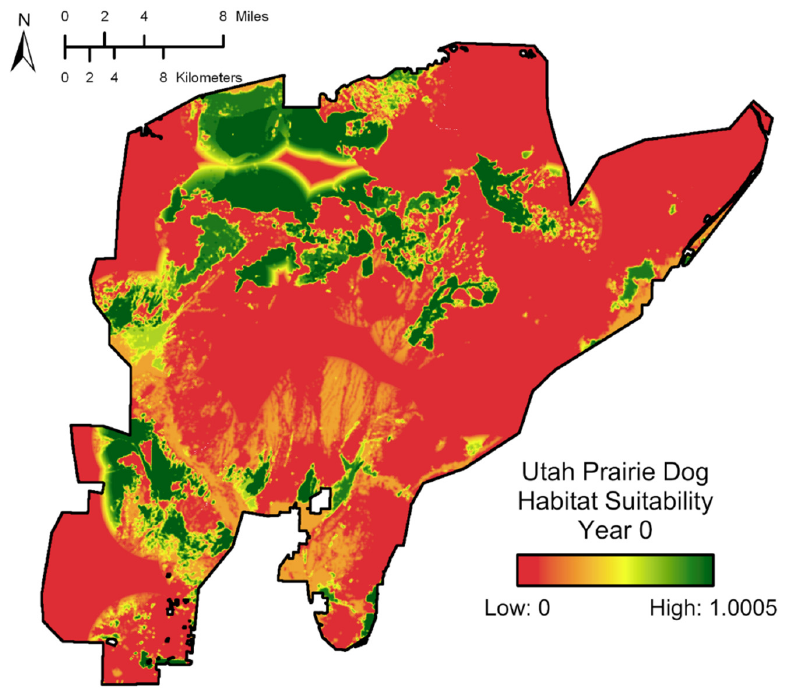
Figure 6. Current (year 0) habitat suitability index for UPD in the Black Mountains based on 2013 five-meter RapidEye satellite imagery. Average habitat suitability for year 0 of simulation was 48.4%. At year 0, there is no difference among management scenarios. Darker green indicates higher habitat suitability index, and redder indicates poorer habitat suitability